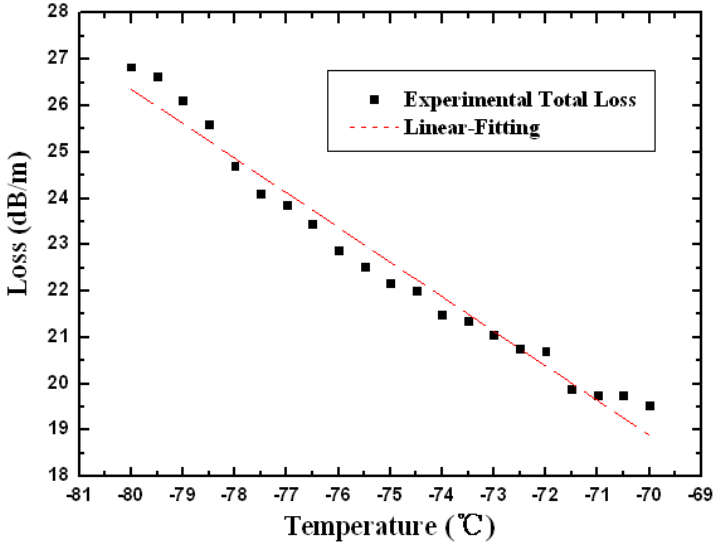
Figure 7. The experimental total loss and linear-fitting curve as functions of temperature in the ultralow range with a 3:7 volume ratio of toluene and